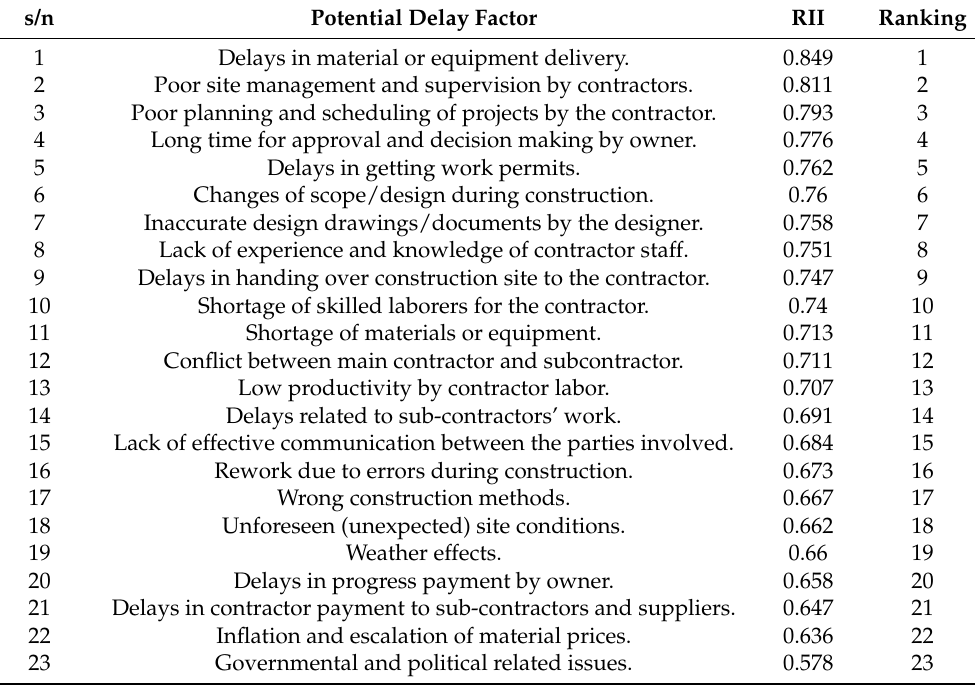
Table 4. The Relative Importance Index (RII).